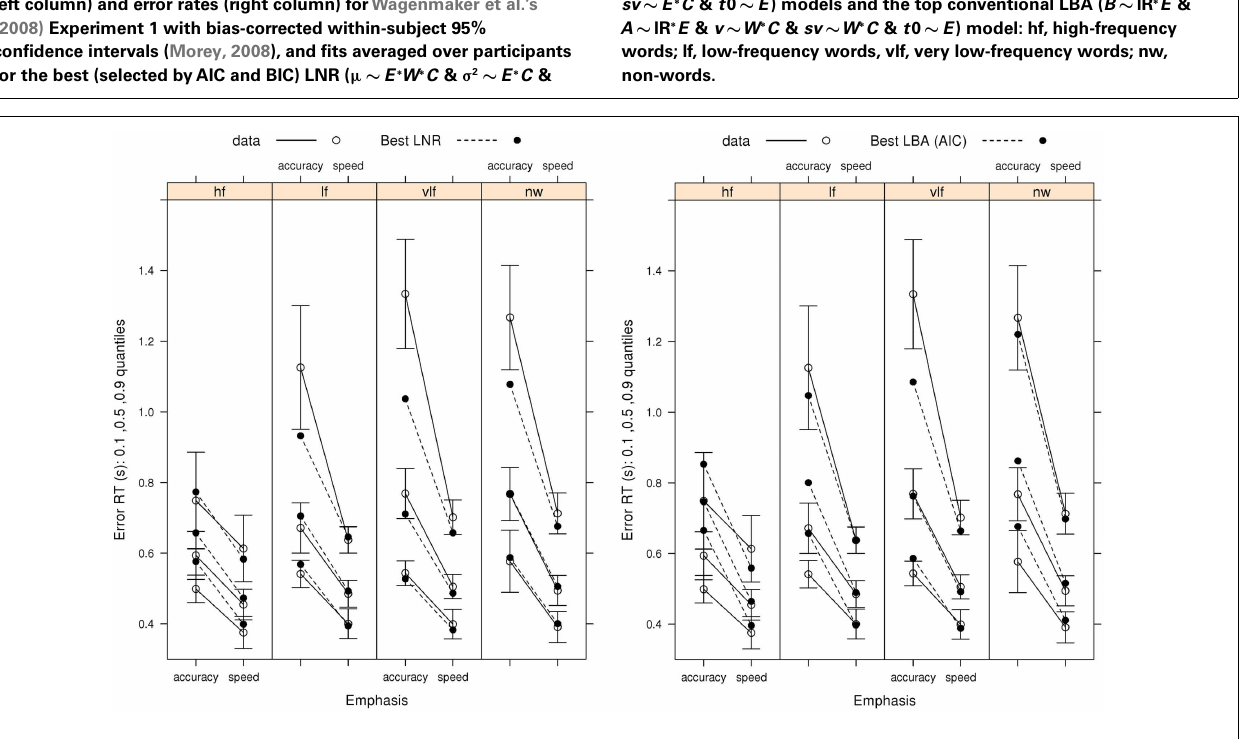
t 0 ∼ E ) and best (selected byAIC) LBA ( B ∼ lR ∗ E & A ∼ E & v ∼ W ∗ C & sv ∼ E ∗ C & t 0 ∼ E ) models and the top conventional LBA ( B ∼ lR ∗ E &